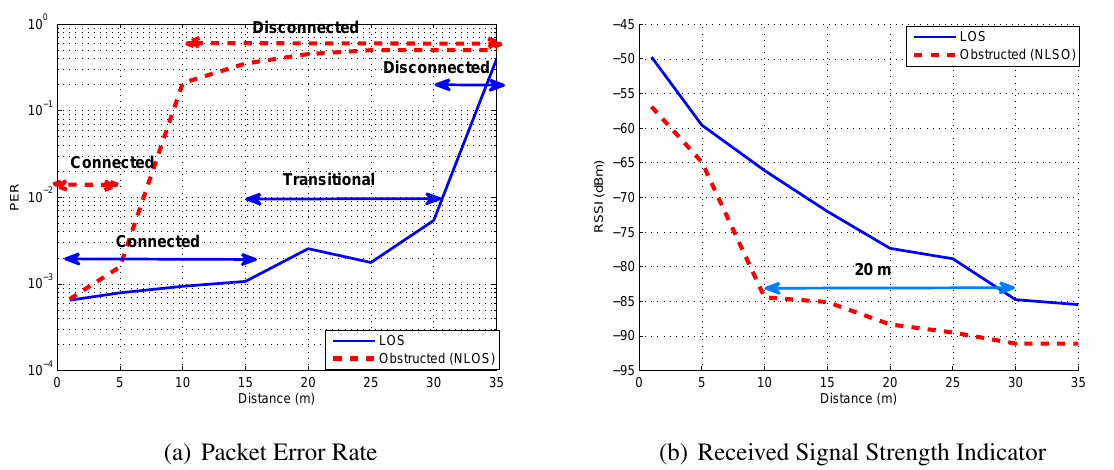
Figure 10. Distance region where two-hop PER is below 5 × 10 − 2 . Corridor